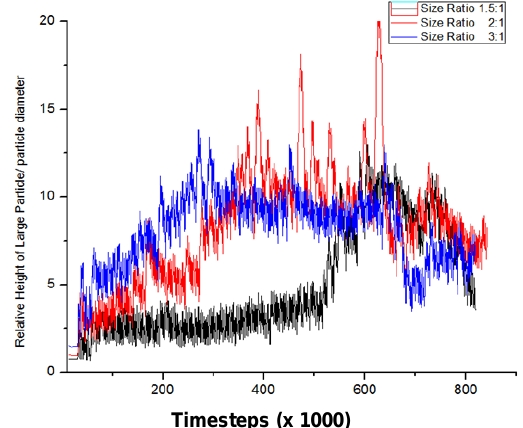
Timesteps (x 1000) Fig. 6. Time evolution of the large intruder ′ s vertical position relative to the vibrated base. Vibration frequency: 20 Hz; vibration amplitude: 10 mm.